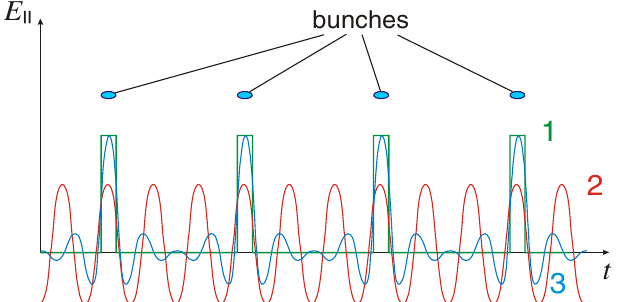
FIG. 2. (Color) Time dependence of fields in an accelerating structure consisting of a chain of uncoupled, multimode, har- monically related eigenmodes. Curve 1 (green) has the ideal time dependence; curve 2 (red) has the sinusoidal time dependence as in conventional single-frequency accelerating structures; curve 3 (blue) represents the field in a multifrequency accelerating structure operating in a limited number of